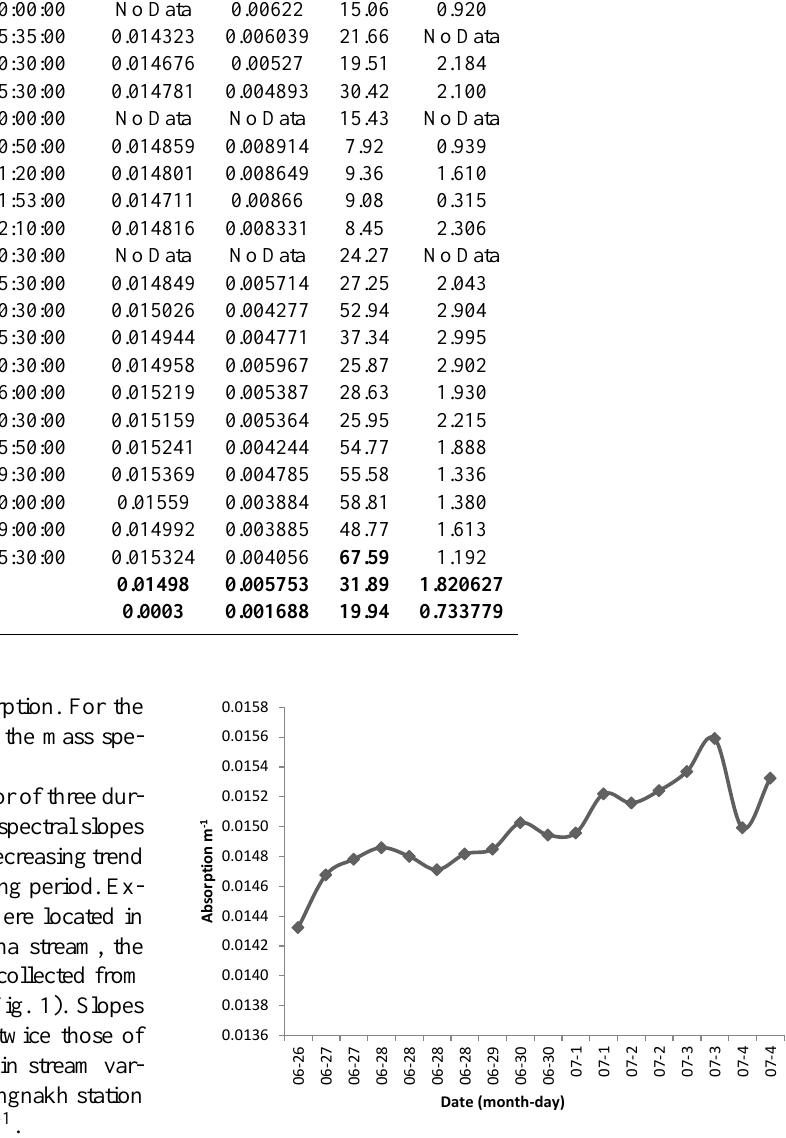
Fig. 4. CDOM semi-logarithmic slopes calculated between 400 and 500nm with 442nm as reference wavelength using a nonlinear fit.